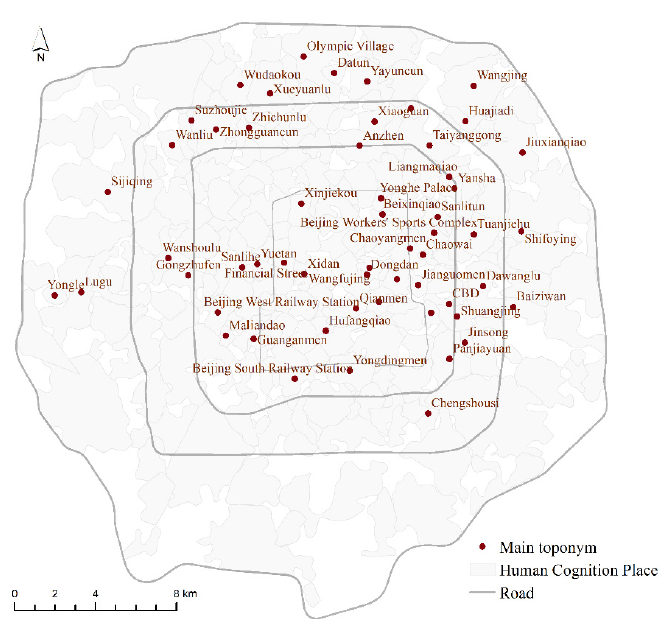
Figure A1. The main toponyms in human cognition in the study area.